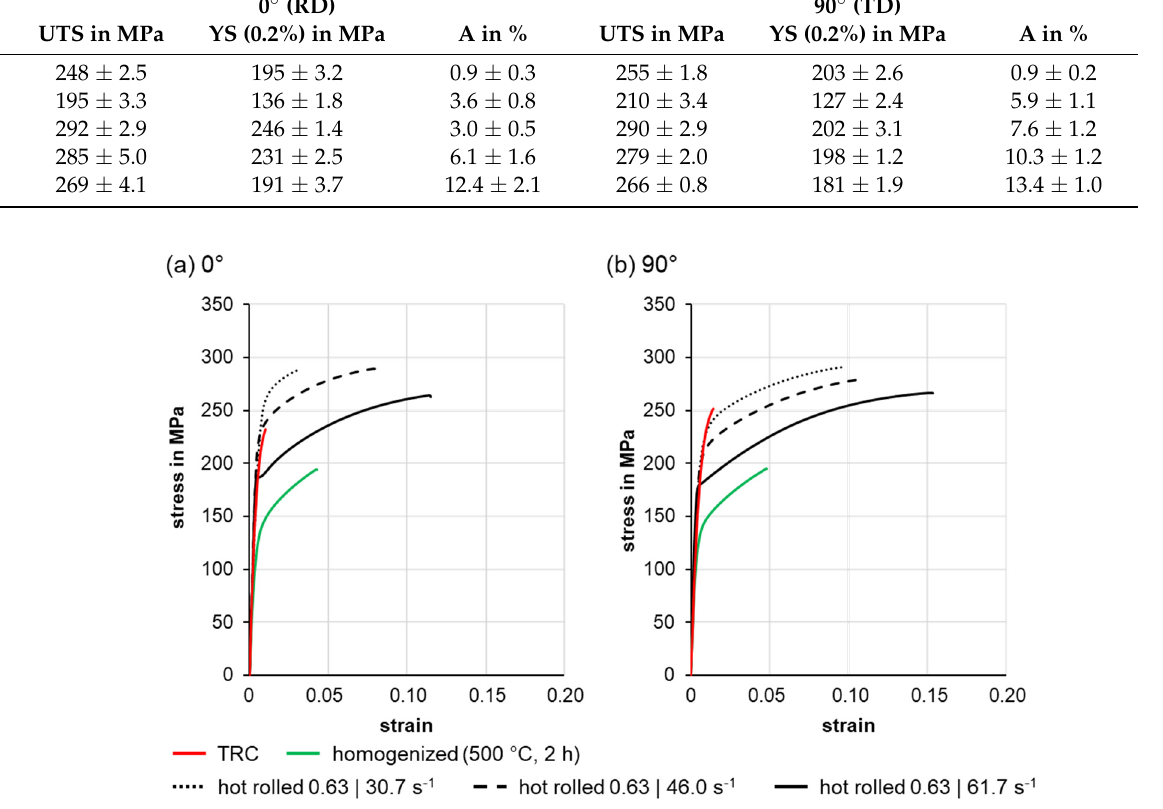
Figure 8. Stress–strain curves of the WZ73 magnesium alloy after twin-roll casting, homogenization, and hot rolling at an equivalent strain of 0.63 and different equivalent strain rates at room temperature ( a ) 0° and ( b ) 90° (shown exemplarily on one of five tested samples).